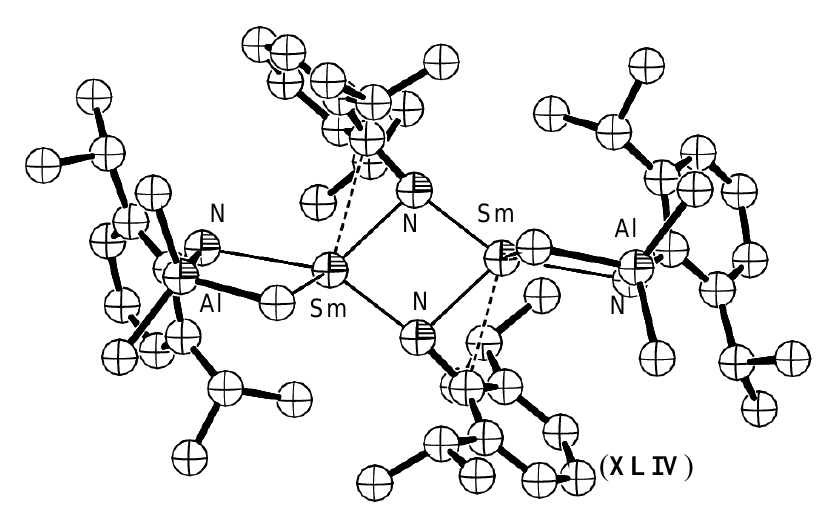
Figure 17. AlMe retained, nitrogen bridged samarium imide complex XLIV . Figure 3 generated from CCDC obtained coordinates. Atoms of arbitrary size. H atoms omitted for clarity